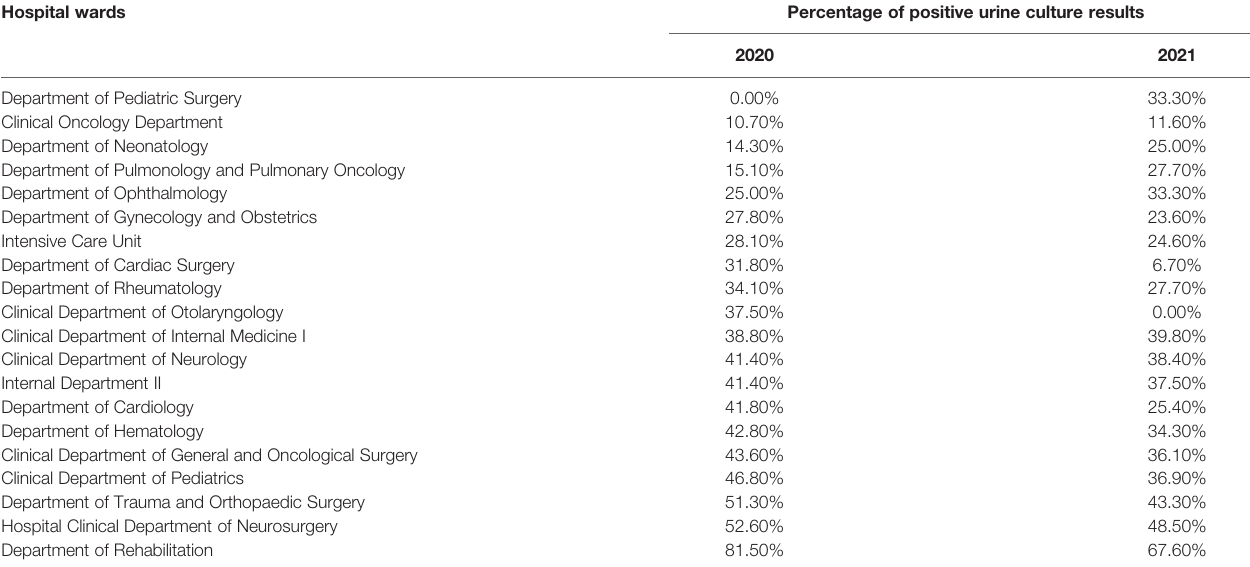
TABLE 1 | Number of positive urine results for individual hospital wards in 2020 and 2021. Hospital